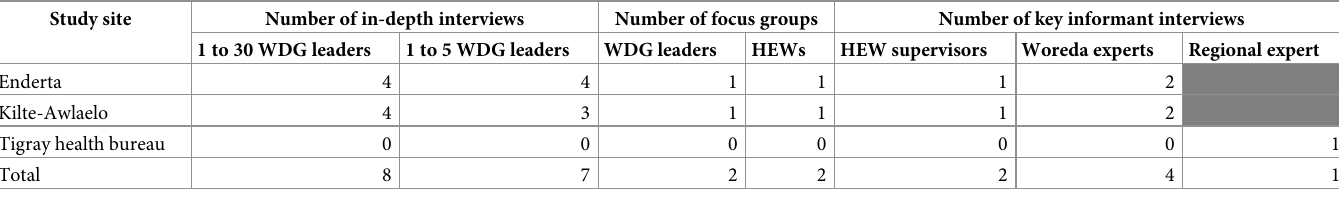
Table 1. Description of participants, Tigray region, Ethiopia, 2018. Study